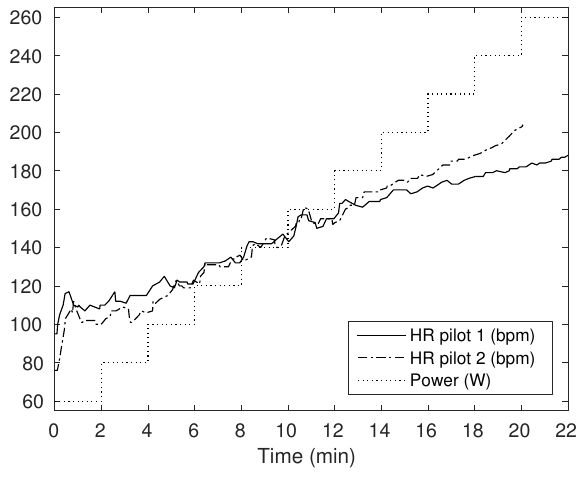
Figure 23. Power test of the